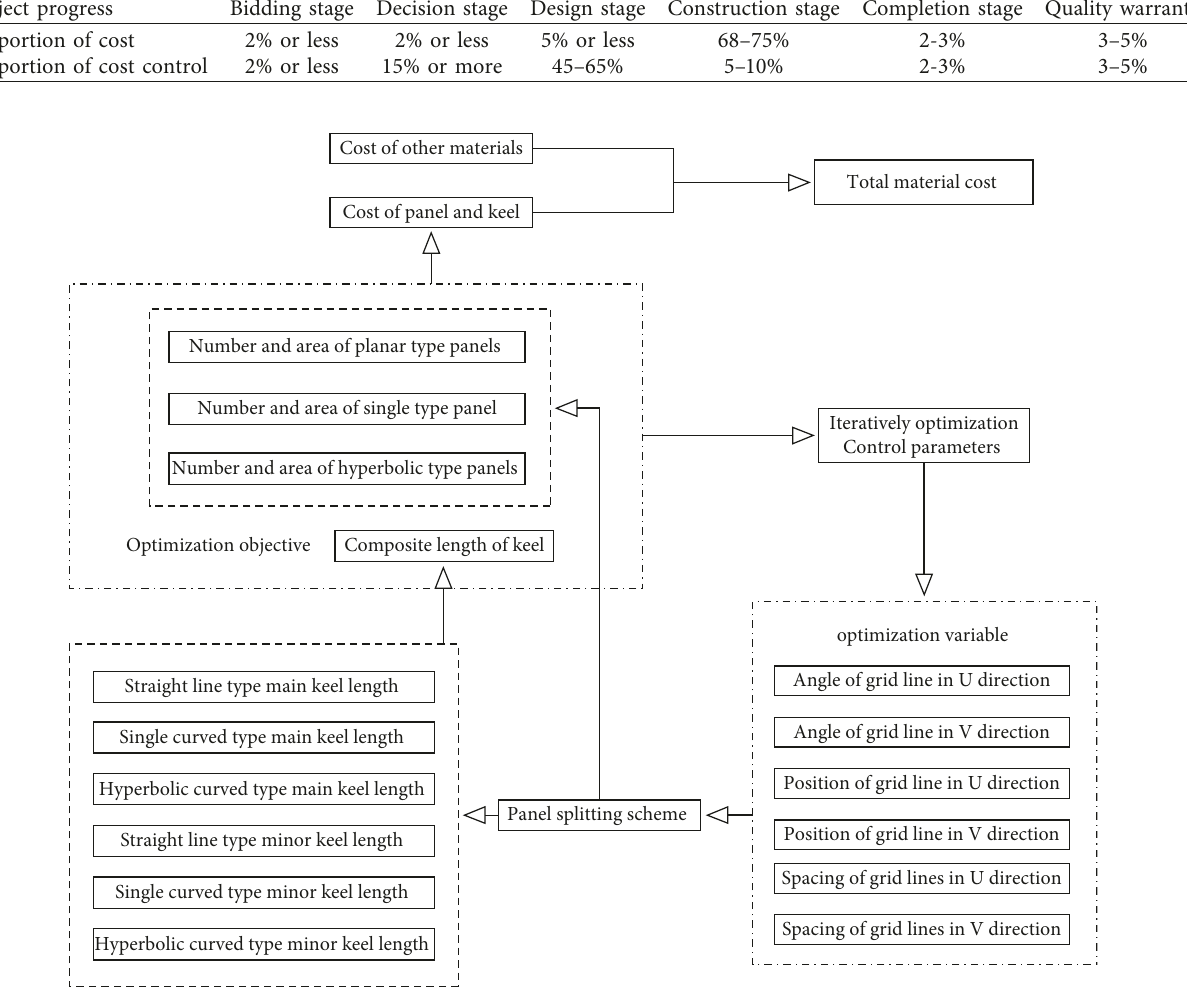
Figure 1: SPEA II multiobjective optimization